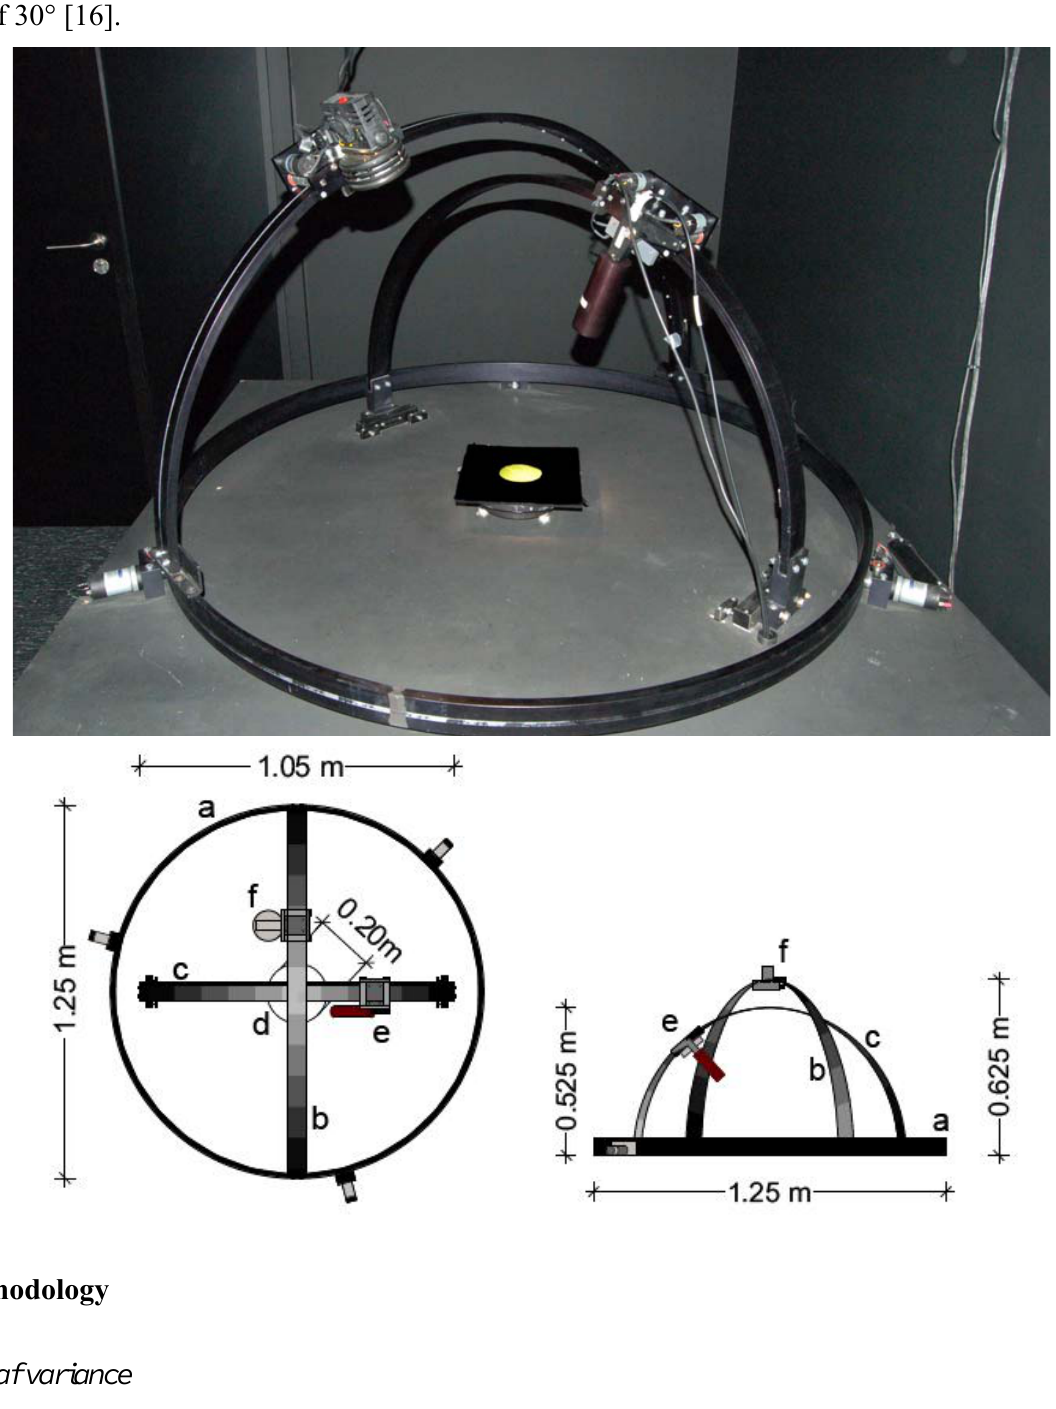
Figure 1. Picture and mechanical system setup of the Compact Laboratory Spectro- Goniometer (CLabSpeG). In the horizontal plane an aluminium rail (a) supports the light source arm (b) and rotates anti-clock wise with an angular sampling step of 30°. A stationary arm (c) supports the hyperspectral sensor. Light source (f) and spectroradiometer (e) have an operational angular sampling step of 15°. In the centre there is the sample holder including a leaf (d), rotating clock-wise with an angular sampling step of 30°